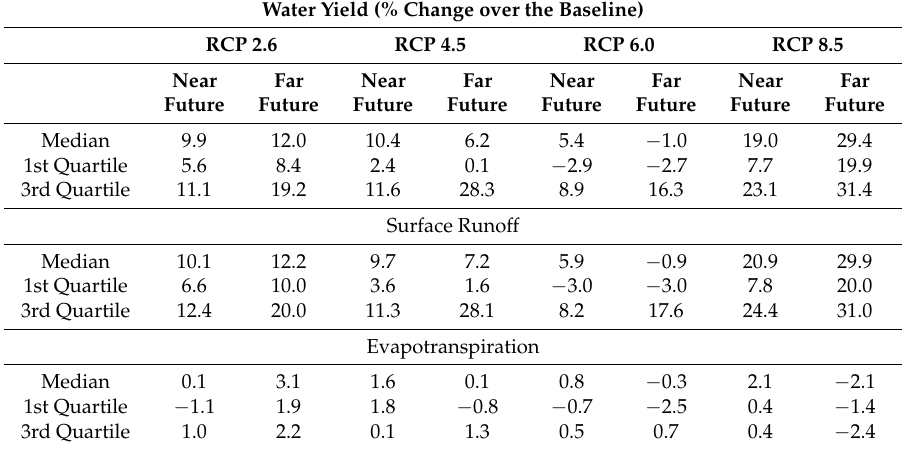
Table 5. Ensemble median and quartiles of annual simulated water yield, surface runoff and ET changes (in percent) for the Goodwater Creek Experimental Watershed.